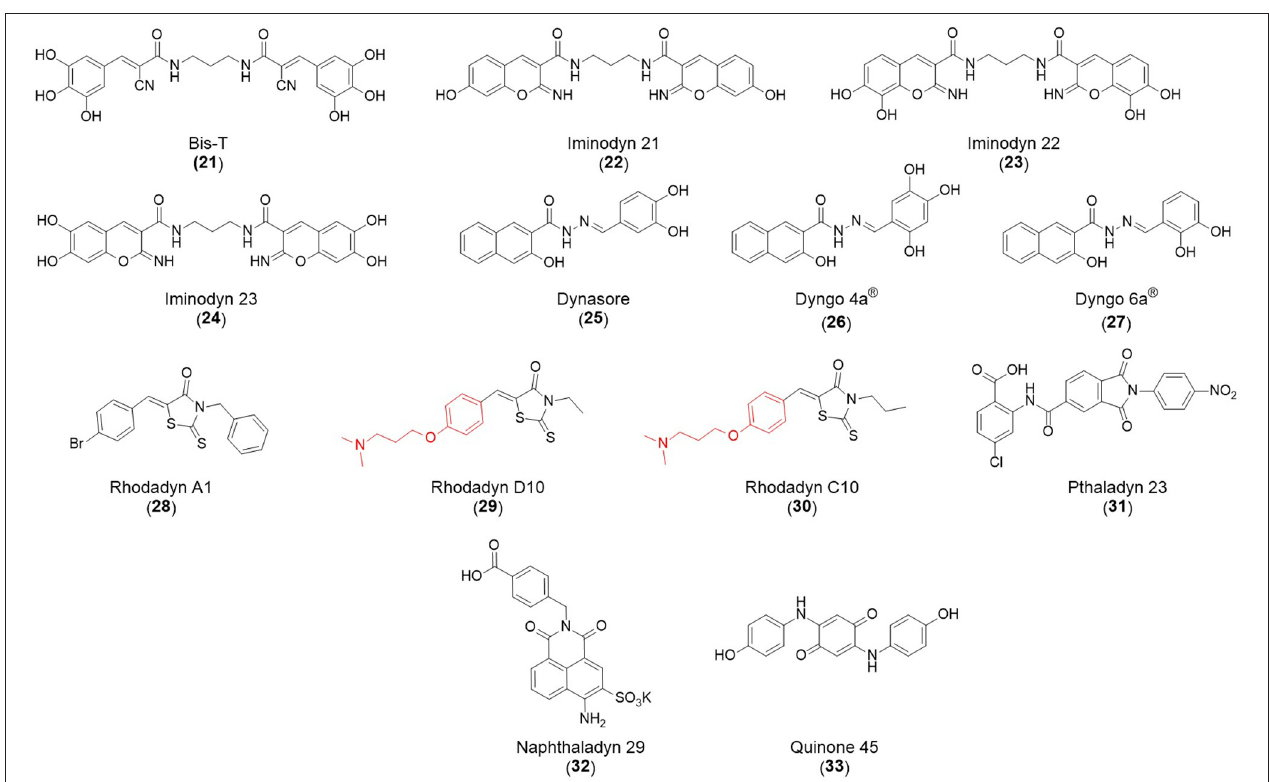
FIGURE 11 | Structure of Bis-T ( 21 ) Iminodyn 21 (22) , Iminodyn 22 (23) , Iminodyn 23 ( 24 ), Dynasore ( 25 ), Dyngo 4a® ( 26 ), Dyngo 6a® ( 27 ), Rhodadyn A1 ( 28 ), Rhodadyn D10 ( 29 ), Rhodadyn C10 ( 30 ), Pthaladyn 23 ( 31 ), Naphthaladyn 29 ( 32 ), and Quinone 45 ( 33 ). The common N,N-dimethyl-3-phenoxypropan-1-amine head group of Rhodadyn D10 ( 29 ) and Rhodadyn C10 ( 30 ) is shown in red.